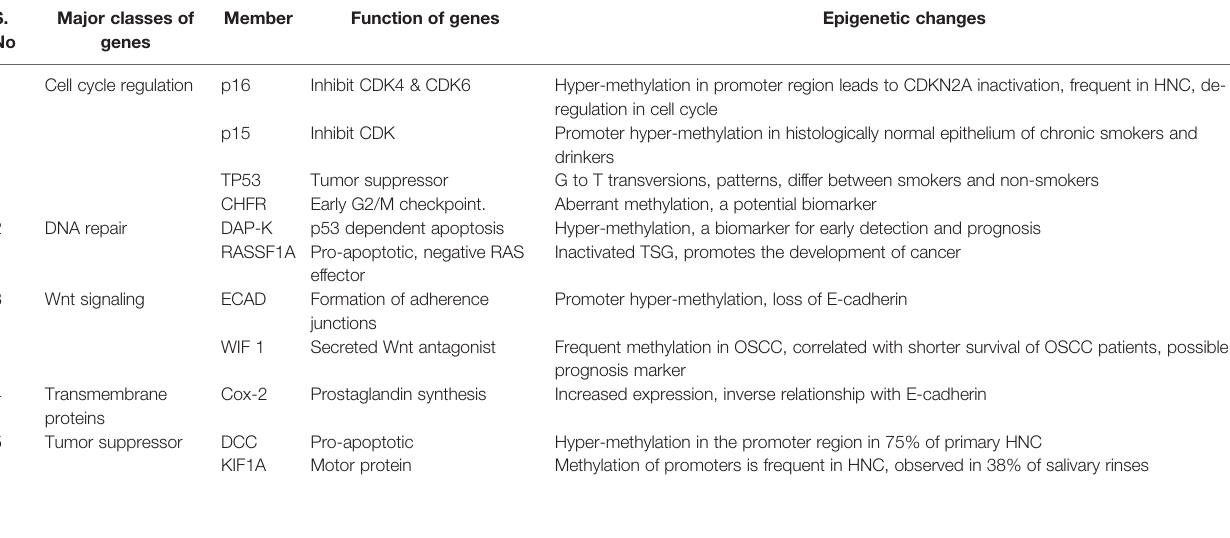
TABLE 3 | The names and functions of genes modi fi ed epigenetically through methylation in HNC and their effects on development and prognosis of HNC. S.